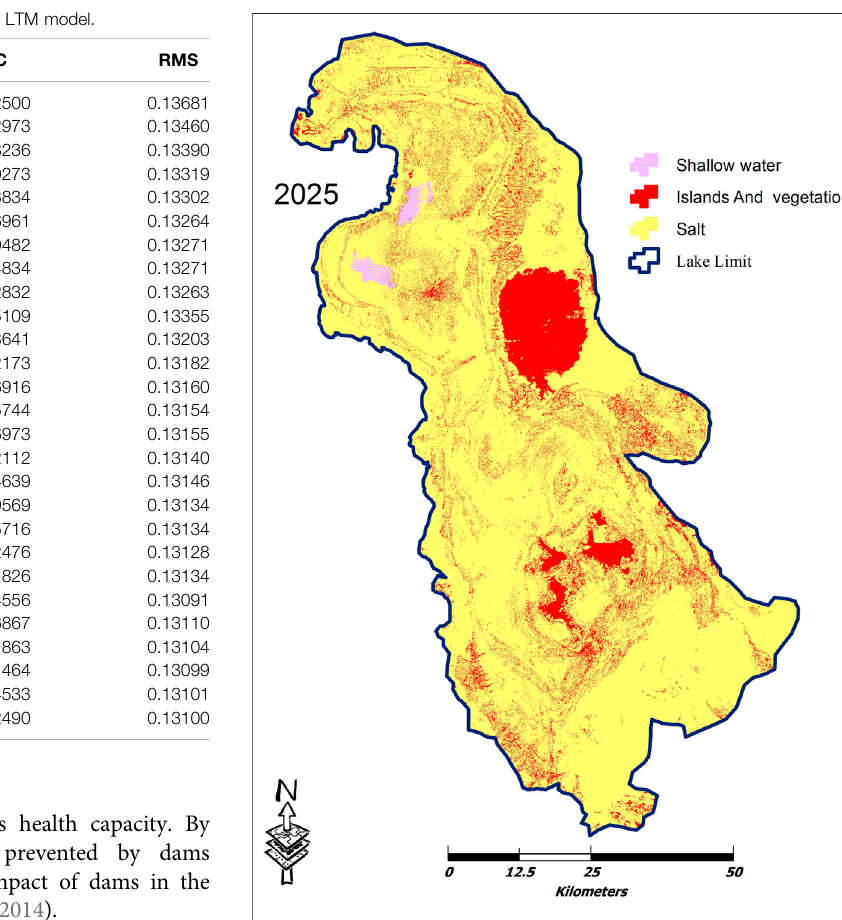
FIGURE 4 | Land-use change probably in 2 (author ’ s illustration).